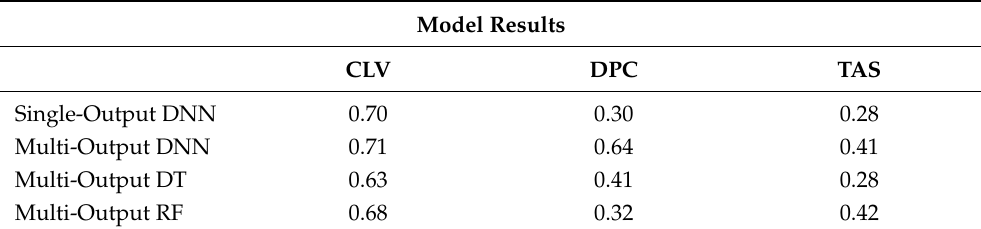
Table 5. Hit-ratios (Top 20%) for single-output vs. multi-output model results. Model